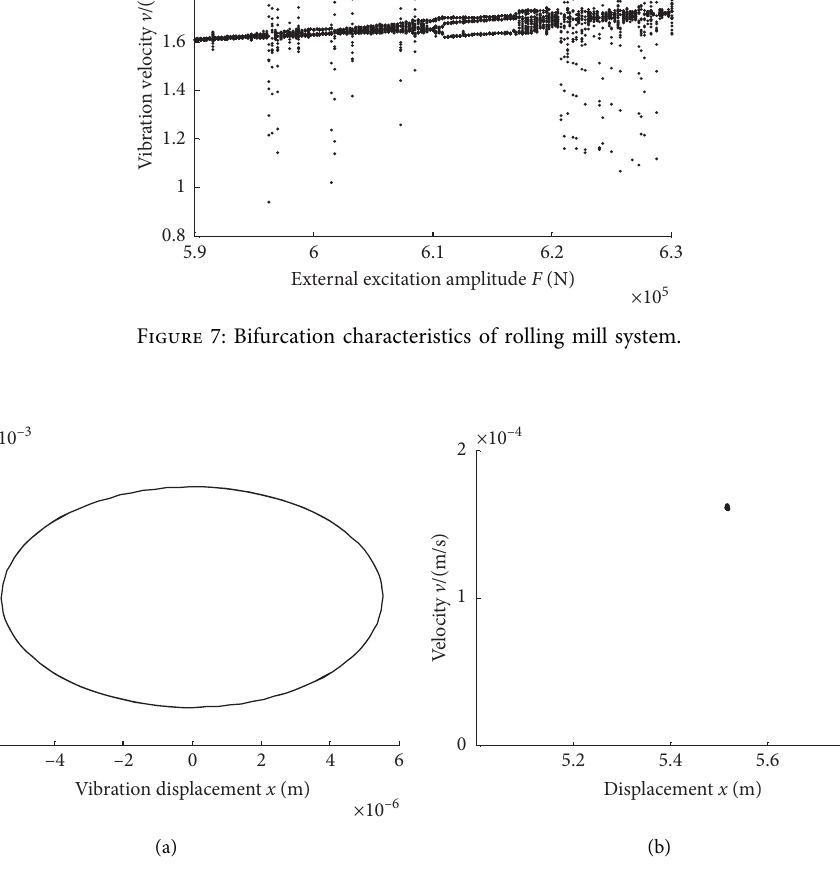
Figure 8: F � 5 . 91 × 10 5 N , 1 time cycle movement. (a) Phase trajectory diagram. (b) Poincar´e